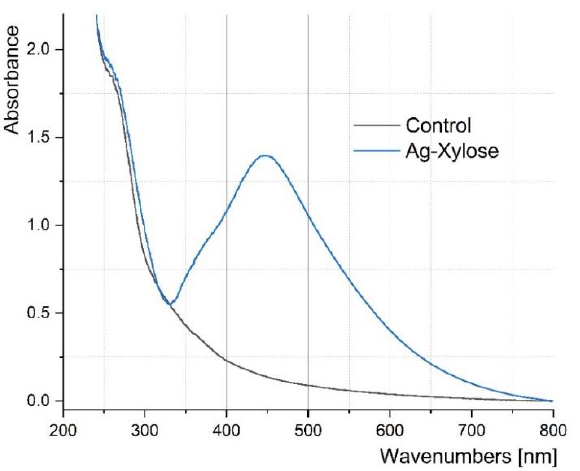
Figure 1. UV–VIs spectra of control (black line) and Ag-xylose (blue line) .